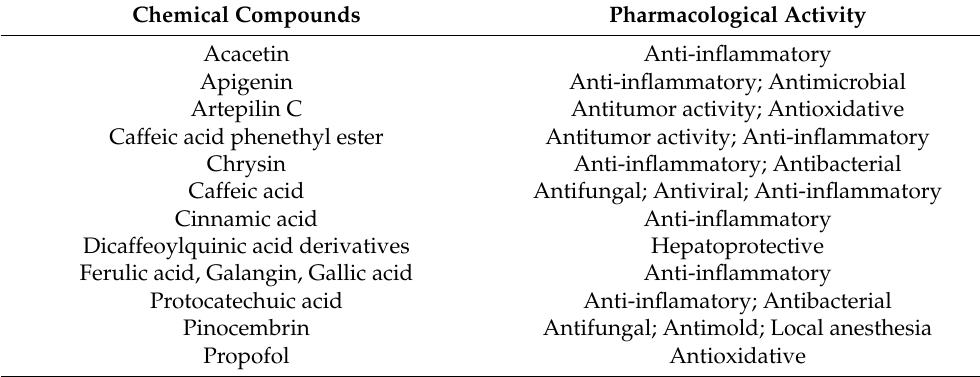
Table 2. The pharmacological activity of chemical propolis compounds—adapted from